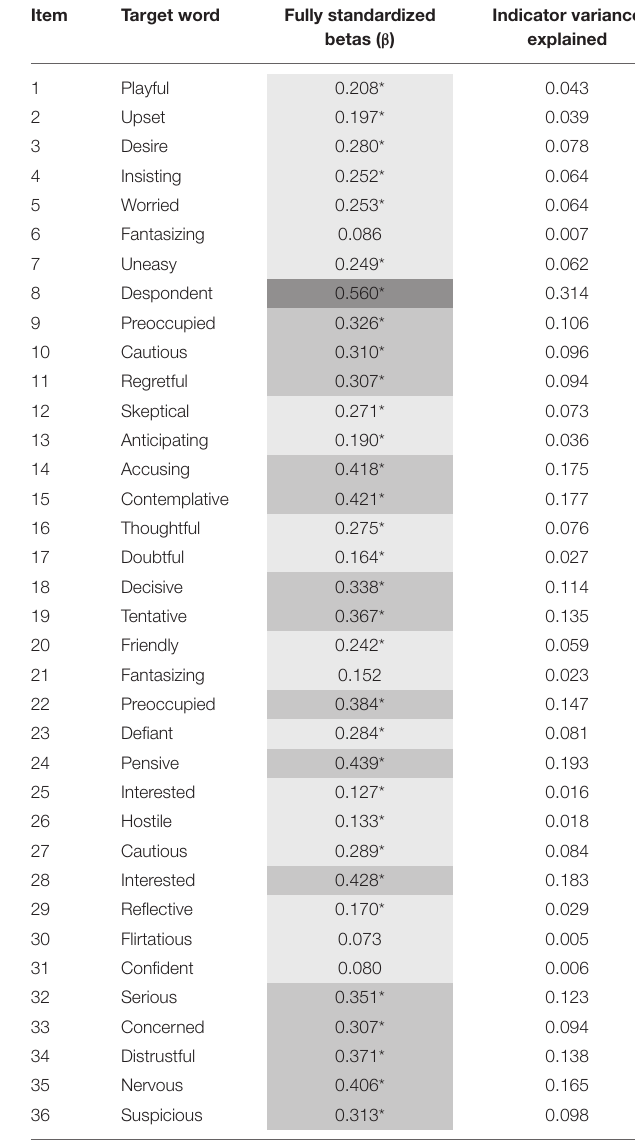
TABLE 2 | Study 1: Exploratory factor analysis: five-factor solution with rotated factor loadings of eyes test items. Item Target Word